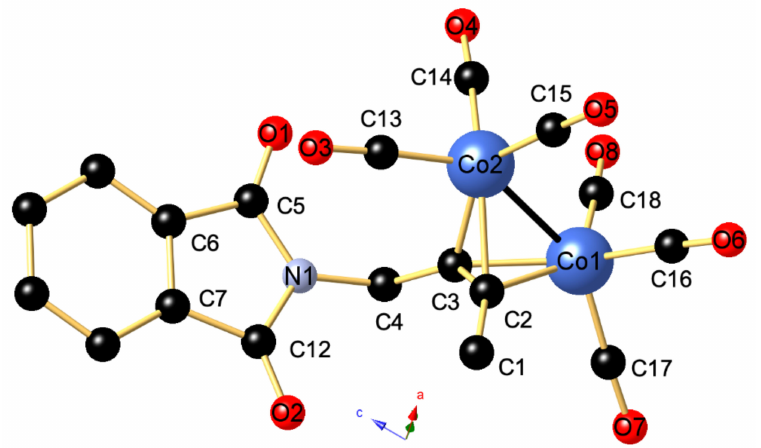
Figure 4. Molecular structure of one of two independent molecules of 2 . All H atoms are omitted for clarity. Selected bond lengths (Å) and angles (deg): Co1–Co2 2.4688(14), Co1–C2 1.980(6),